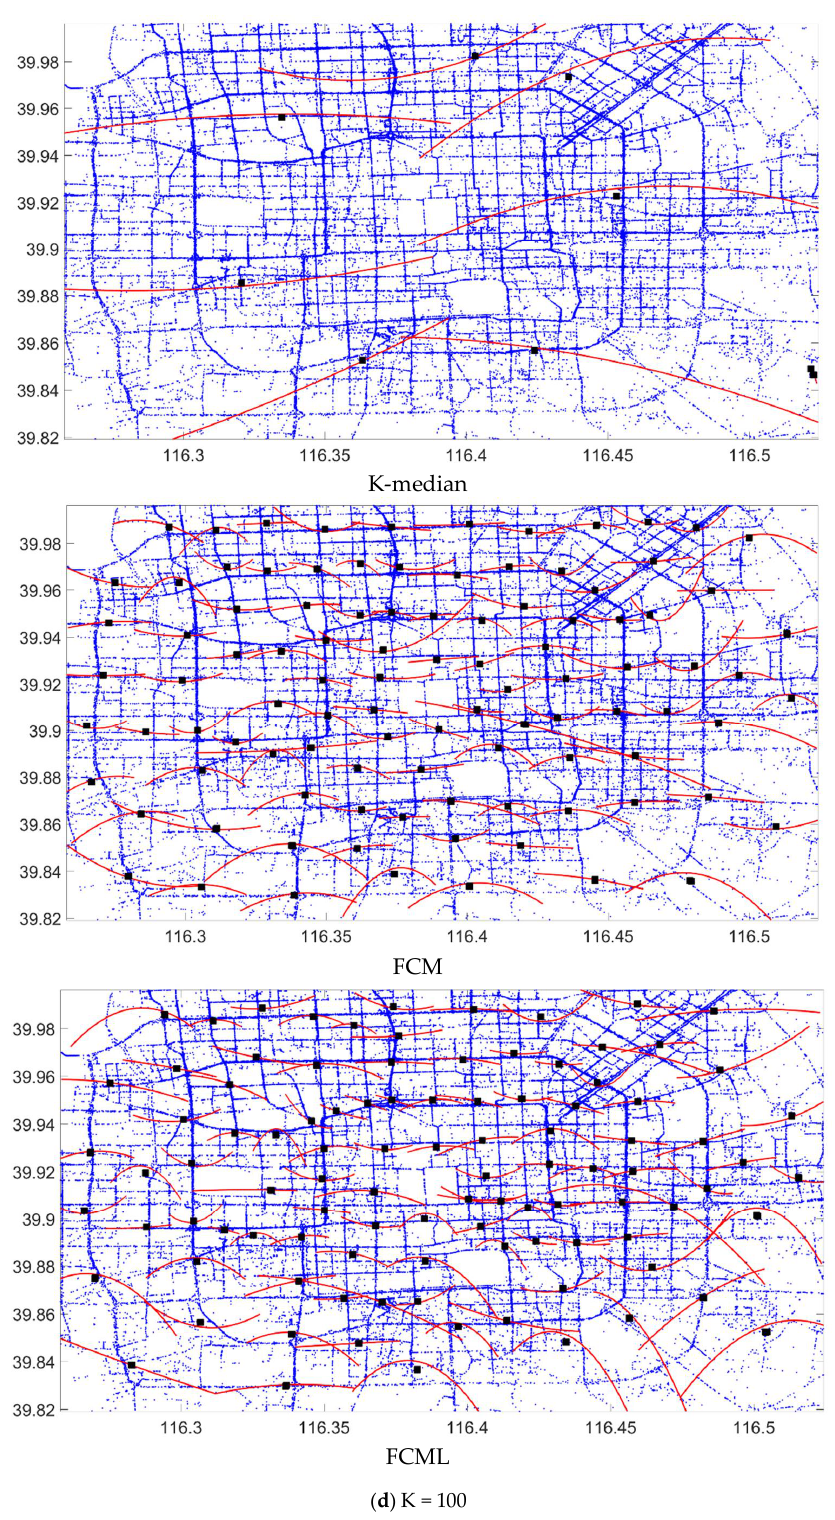
Figure 13. The trajectory regression clustering results of real-world taxi GPS data shown in Figure 2 using K-means, K-median, FCM, and FCML on the different cluster numbers: ( a ) K = 20, ( b ) K = 40, ( c ) K = 80, and ( d ) K = 100.